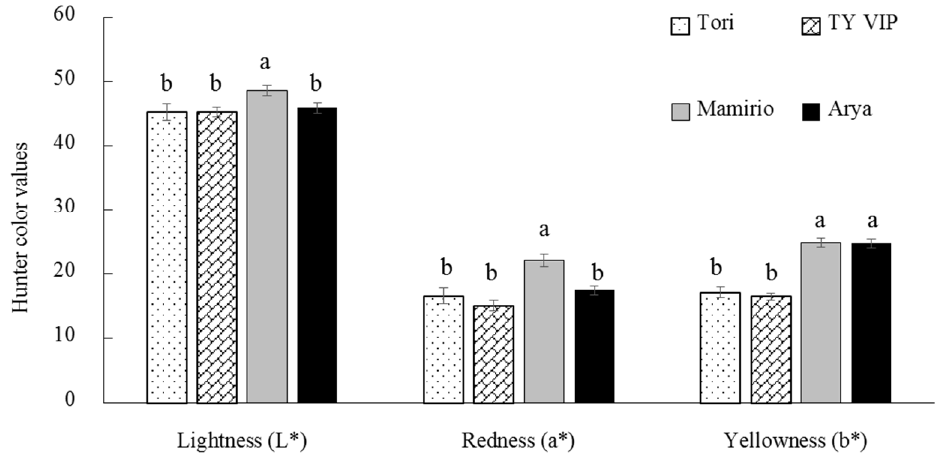
Figure 1. Hunter’s L *, a *, and b *color values of ‘Tori’, ‘TY VIP’, ‘Mamirio’, and ‘Arya’ tomato cultivars at the commercial pink ripening stage. The bars with different letters indicate a significant difference ( p < 0.05) between cultivars. The vertical bars represent the standard error of the means ( n = 5).